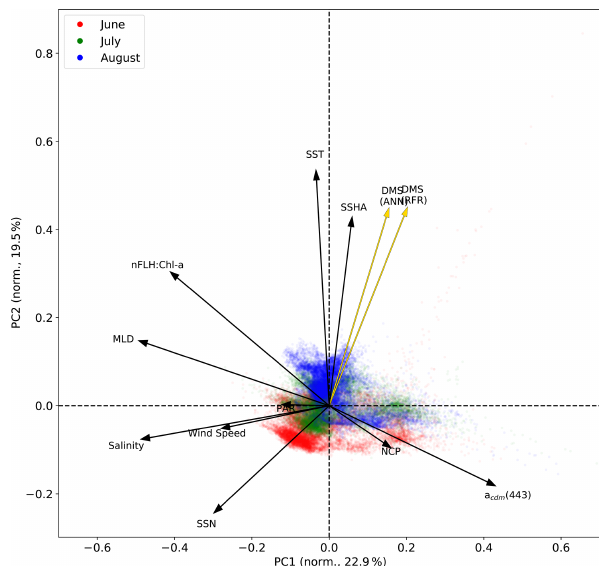
Figure 6. Principal component analysis (PCA) showing the rela- tionships between variables used to construct the predictive algo- rithms. Eigenvectors (arrows) are superimposed over the principal components (PCs; data points) for the first two significant modes obtained from PCA. PCs are normalized and clustered by month (June–August, see legend for colours), while the eigenvectors are grouped by ensemble model predictions (gold) and nine predictor variables (black). The percentage of variance explained by each mode is indicated along the axes.